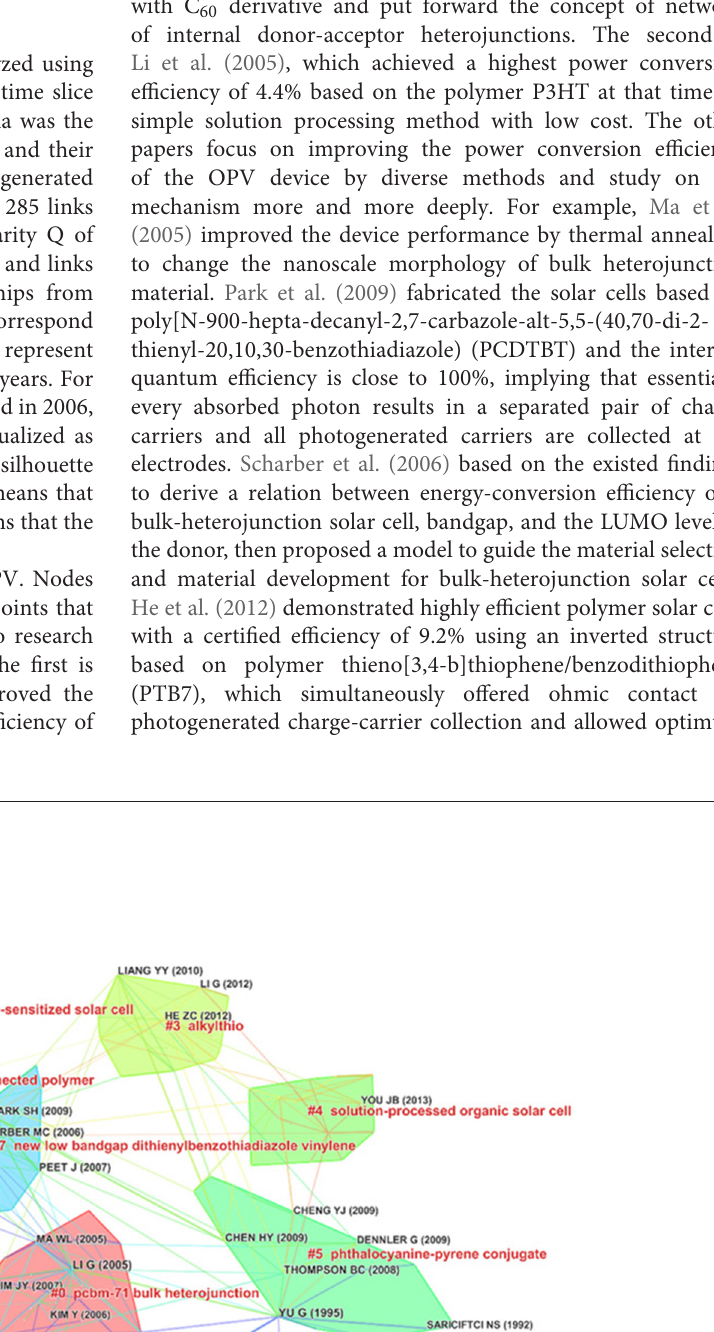
Frontiers in Chemistry |